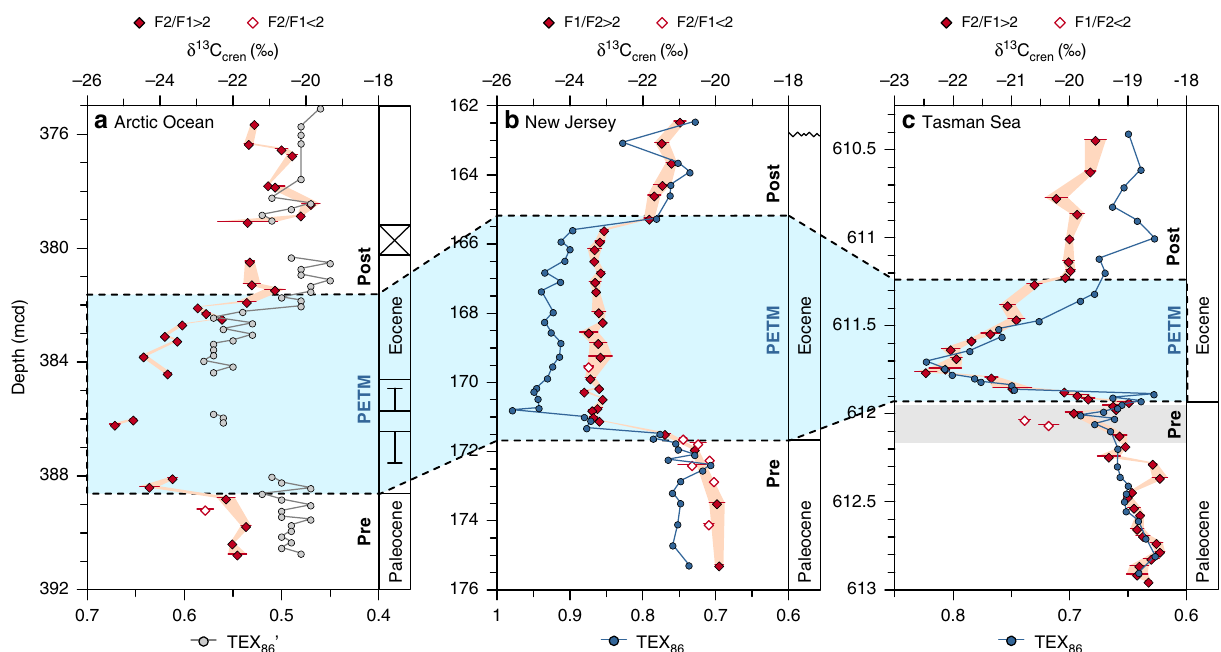
Fig. 2 Coupled ocean temperature proxy and crenarchaeol stable carbon isotope data across the Paleocene-Eocene Thermal Maximum. TEX 86 and TEX 86 ’ index values (plotted on an inverted axis; Arctic Ocean: ref. 43 , New Jersey shelf: this study, Tasman Sea: ref. 36 ) and carbon isotopic ratios of crenarchaeol ( δ 13 C cren ) during the late Paleocene and early Eocene at three globally distributed sites ( a , Arctic Ocean; b , New Jersey shelf; c , Tasman Sea; as in Fig. 1). Error bars for δ 13 C cren represent one standard deviation of replicate analyses ( n = 5). Error bars of δ 13 C cren are not displayed where they are smaller than the